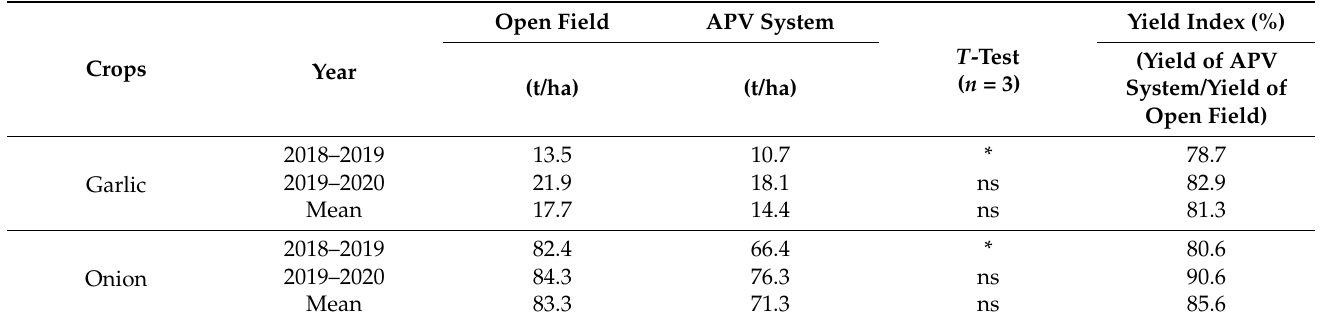
Table 3. Mean of yield test for garlic and onion between the agro-photovoltaic system and the open field over two